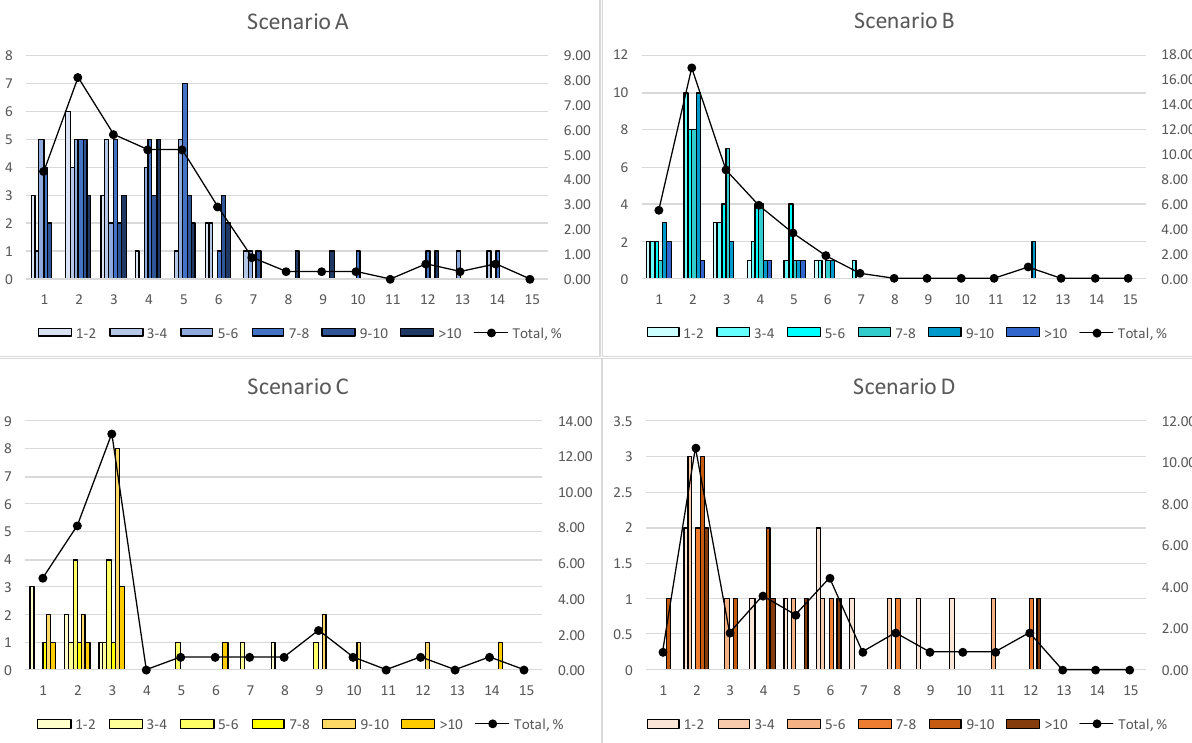
Figure 7. Number of rods replaced across the x axis as time (years) in the lifecycle of the Afridev when water point has undergone rehabilitation.